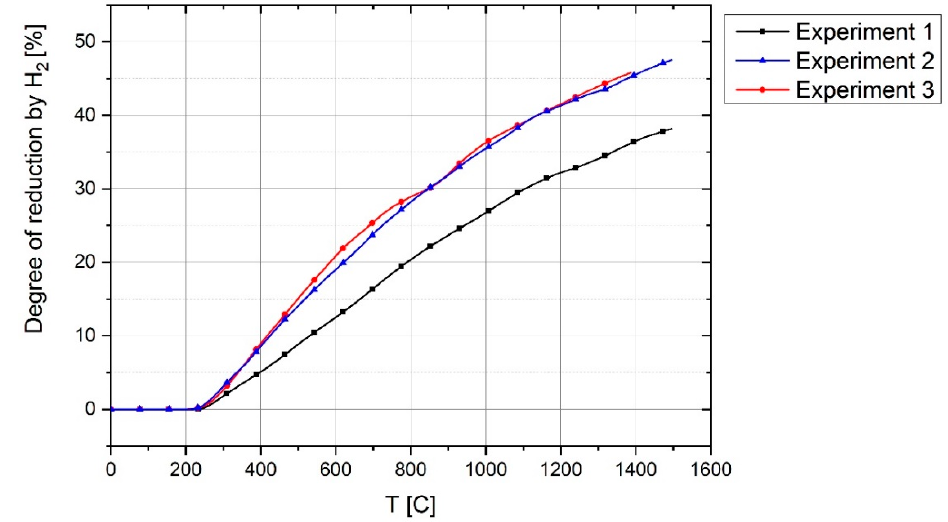
Figure 16. The degree of reduction of iron oxide in Experiments 1, 2 and 3.